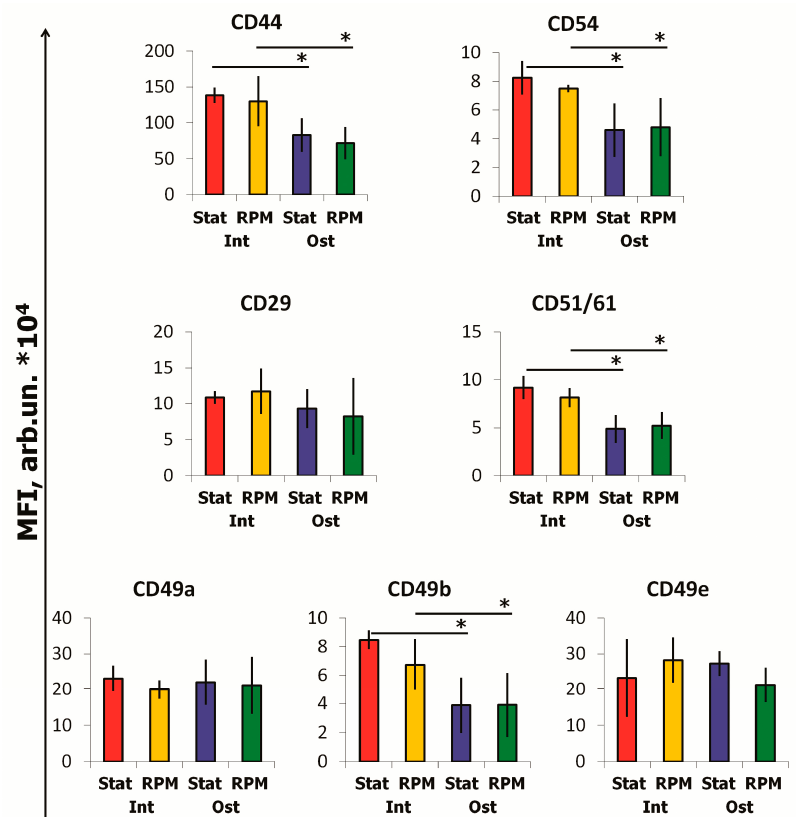
Figure 6. Expression of adhesion molecules on MSCs after 10-days of RPM exposure, flow cytometry. Data are presented as mean ± SD; n ≥ 3, * p < 0.05. MSCs—mesenchymal stromal cells; Int—intact cells; Ost—osteocommitted cells; Stat—static control; RPM—random positioning machine; MFI—mean fluorescence